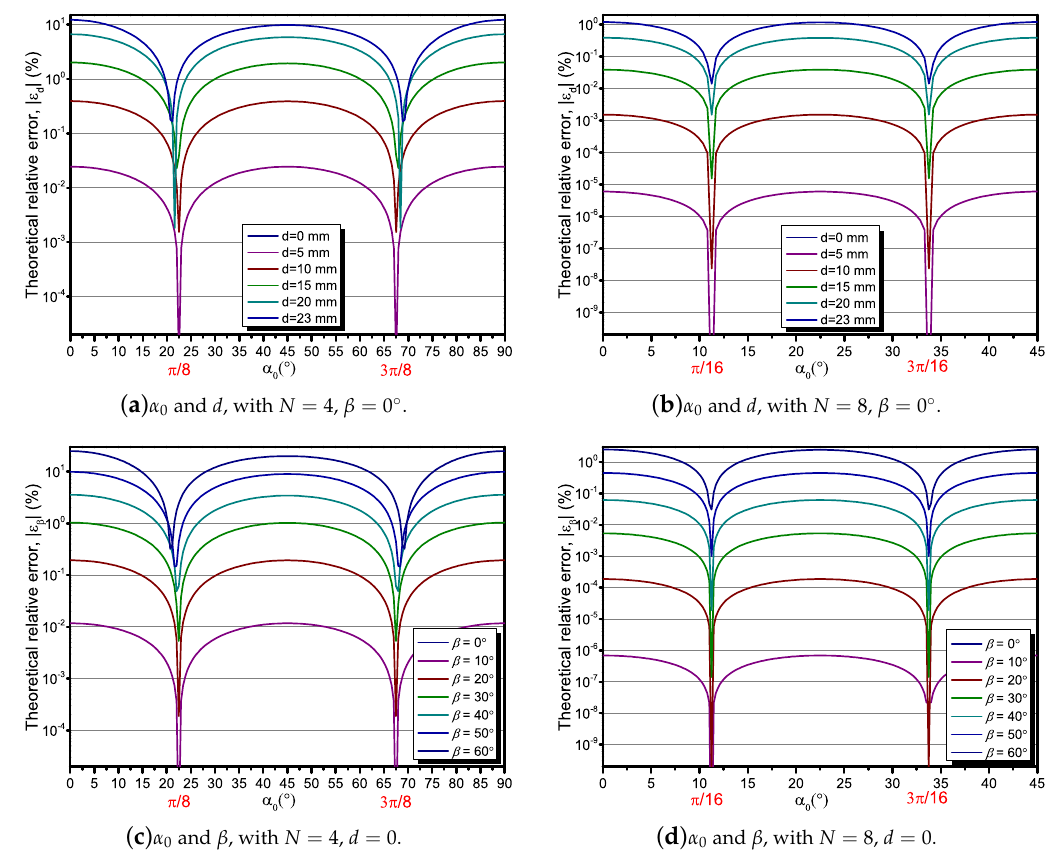
( c ) α 0 and β , with N = 4, d = 0. Figure 3. The theoretical relative error analysis depending on α 0 , β , and d , with r 0 = 40